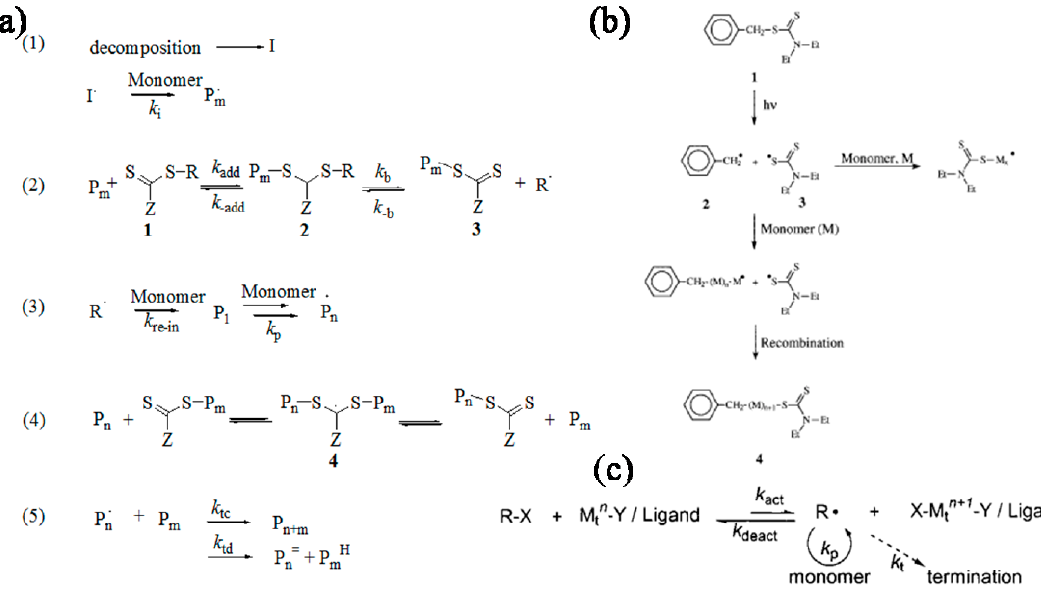
Figure 1. ( a ) Generally accepted mechanism for a RAFT polymerization. Copyright 2009, American Chemical Society; ( b ) The mechanism for NMRP polymerization. Copyright 2001, American Chemical Society; ( c ) Transition-metal-catalyzed ATRP. Copyright 2001, American Chemical Society.